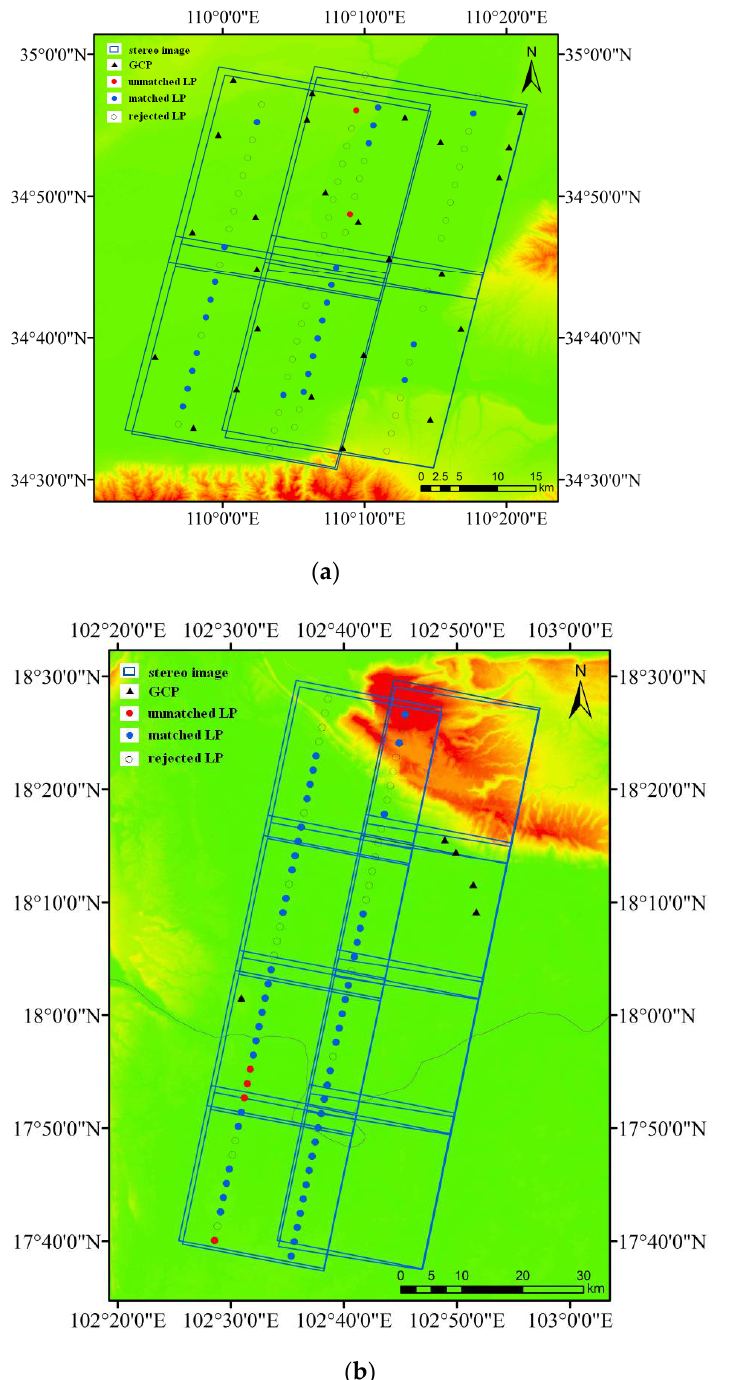
Figure 6. Study areas and distributions of experimental data. ( a ) Shaanxi area; ( b ) Laos–Thailand border area.